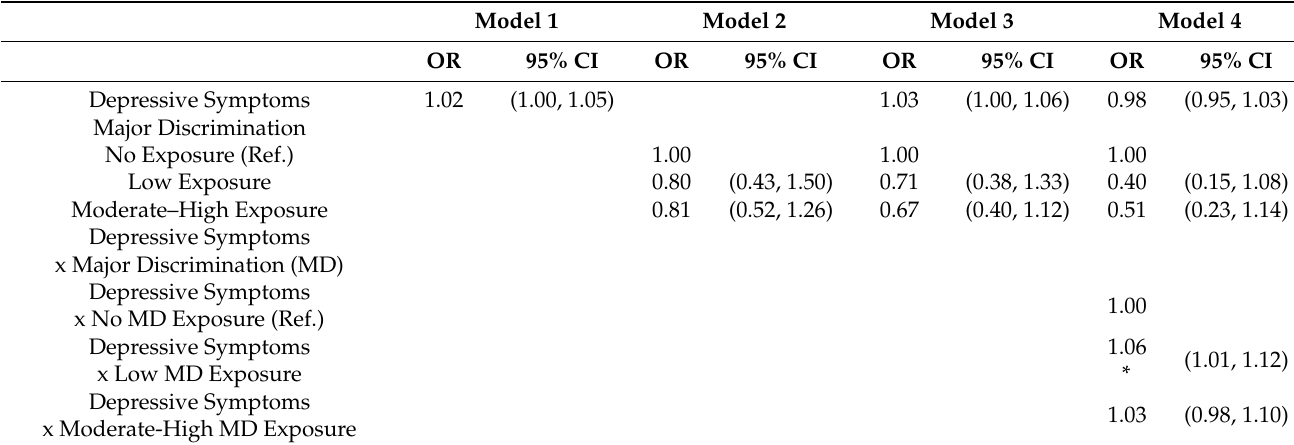
Table 3. Chronic Conditions Regressed on Depressive Symptoms and Lifetime Major Discrimination among Black Men, Nashville Stress and Health Study (2011–2014).